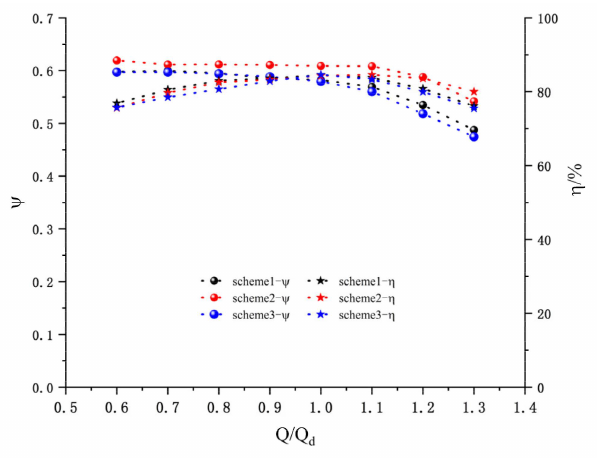
Figure 4. External characteristics under di ff erent